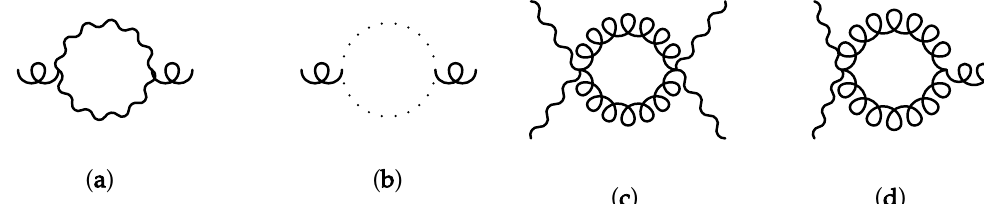
Figure 4. matter-involving diagrams Figure 4. Matter-involving diagrams.